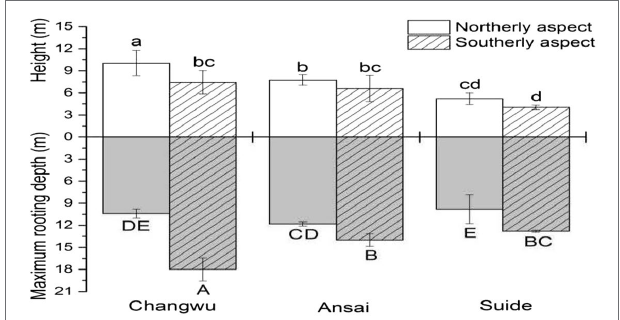
FIGURE 4 | Mean stand heights and the depth of the root front at Changwu, Ansai, and Suide. Vertical bars indicate standard deviations. Lowercase letters indicate significant differences in stand height and uppercase letters indicate significant differences in the depth of the root front (n = 3, p <